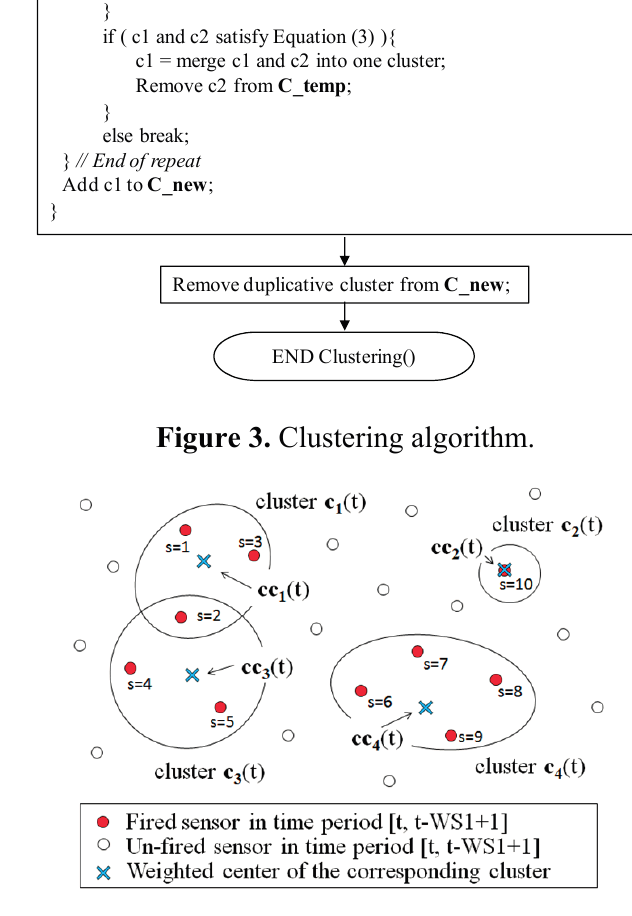
Figure 4. Example of